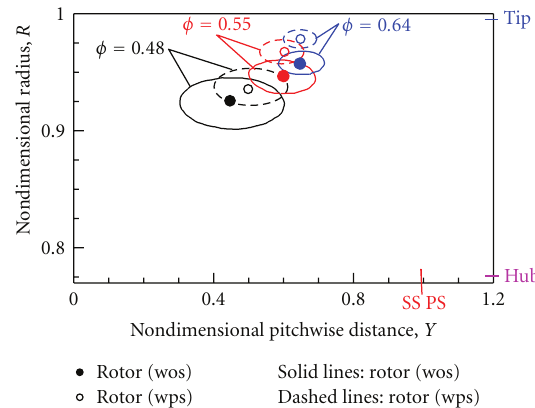
Figure 14: Location and extent of leakage vortex at di ff erent flow coe ffi